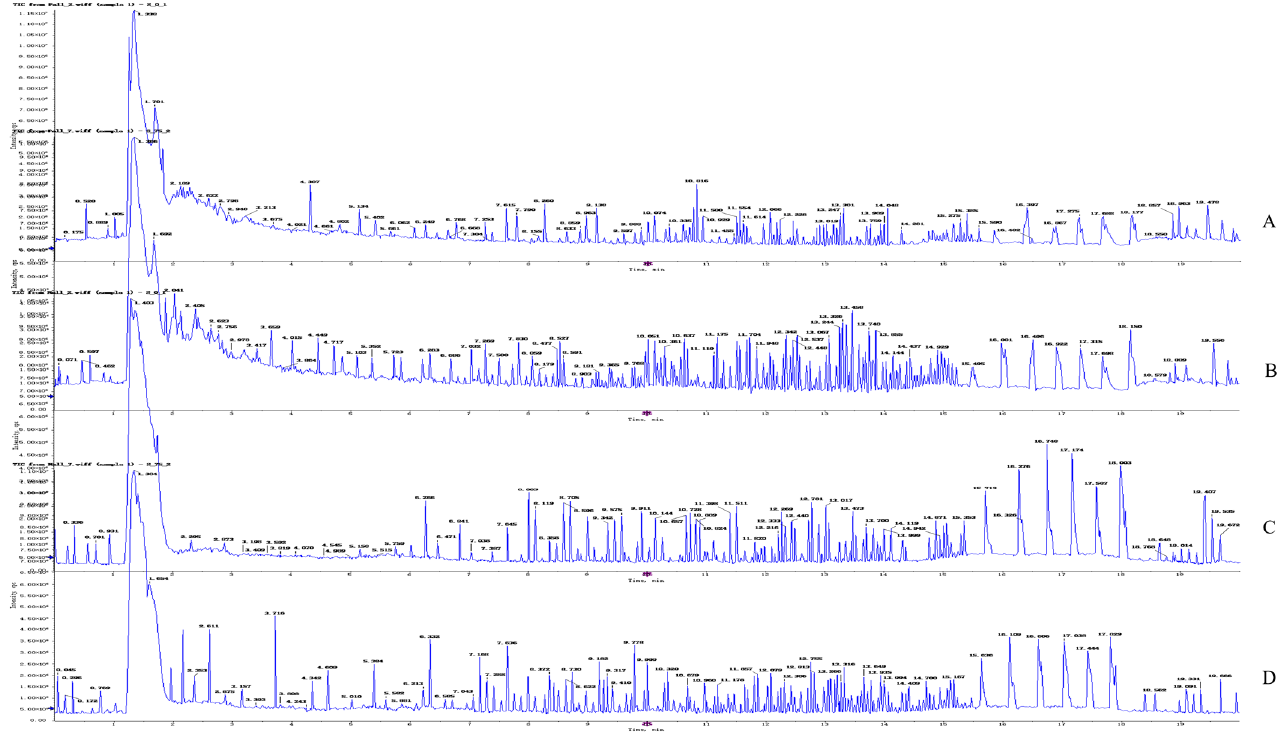
Figure 6. Representative total ion chromatogram obtained for metabolite profiles in 4T1 cells after osthole (OST) treatment. ESI + mode: ( A ) control group; ( B ) 75 μ M OST; ESI ‐ mode: ( C ) control group; ( D ) 75 μ M OST.